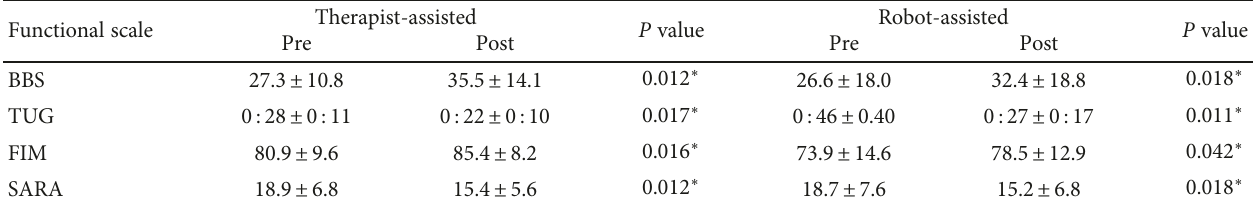
Table 2: Outcome measures at baseline and after protocol treatment by intervention therapy. Functional